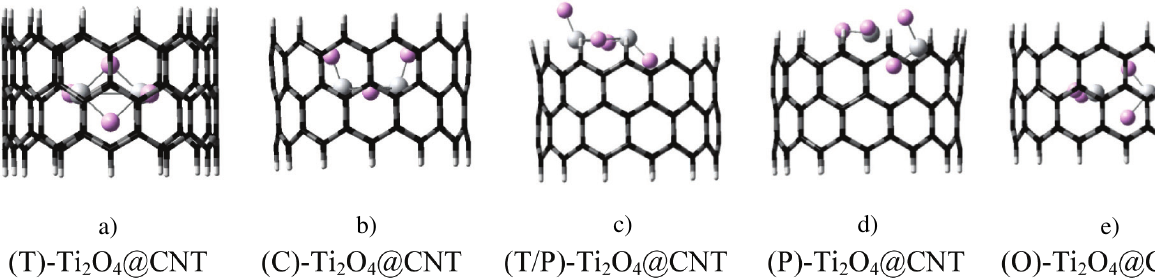
Figure 5 . Optimized dispositions of studied dimers into the carbon nanotube (12,0).